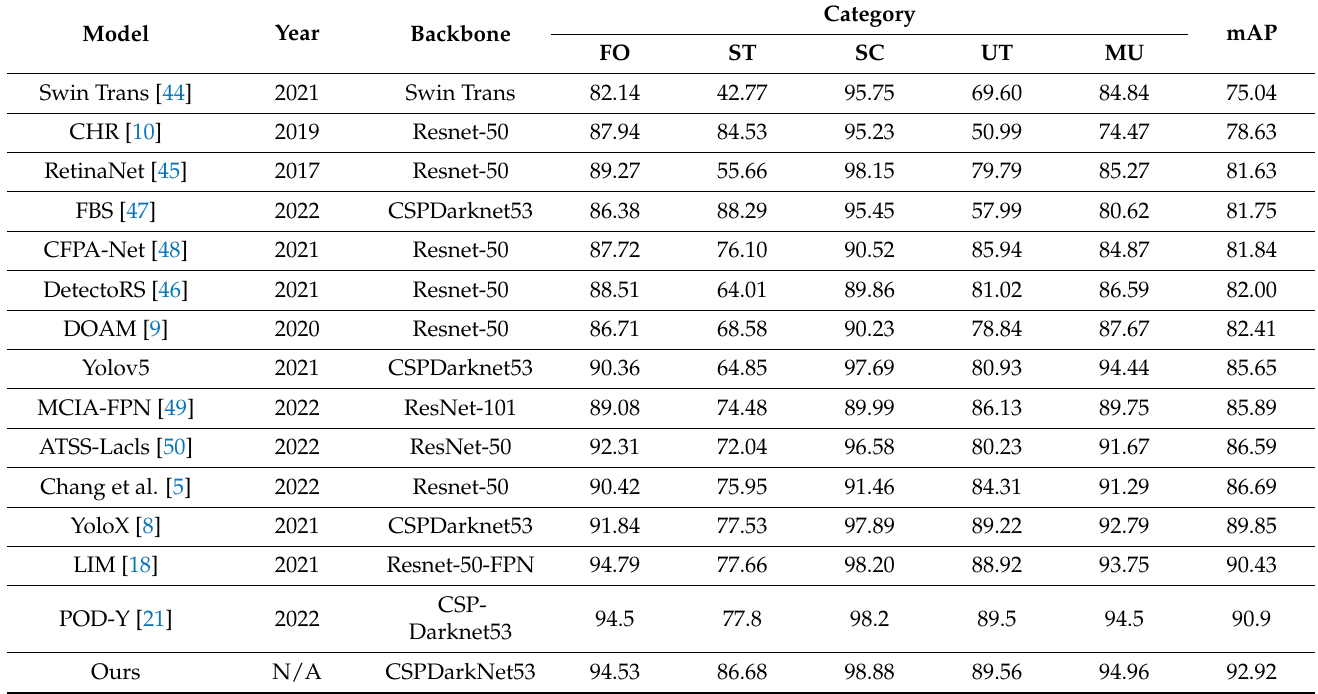
Table 1. Performance comparison results using different object detection methods on the OPIXray dataset.